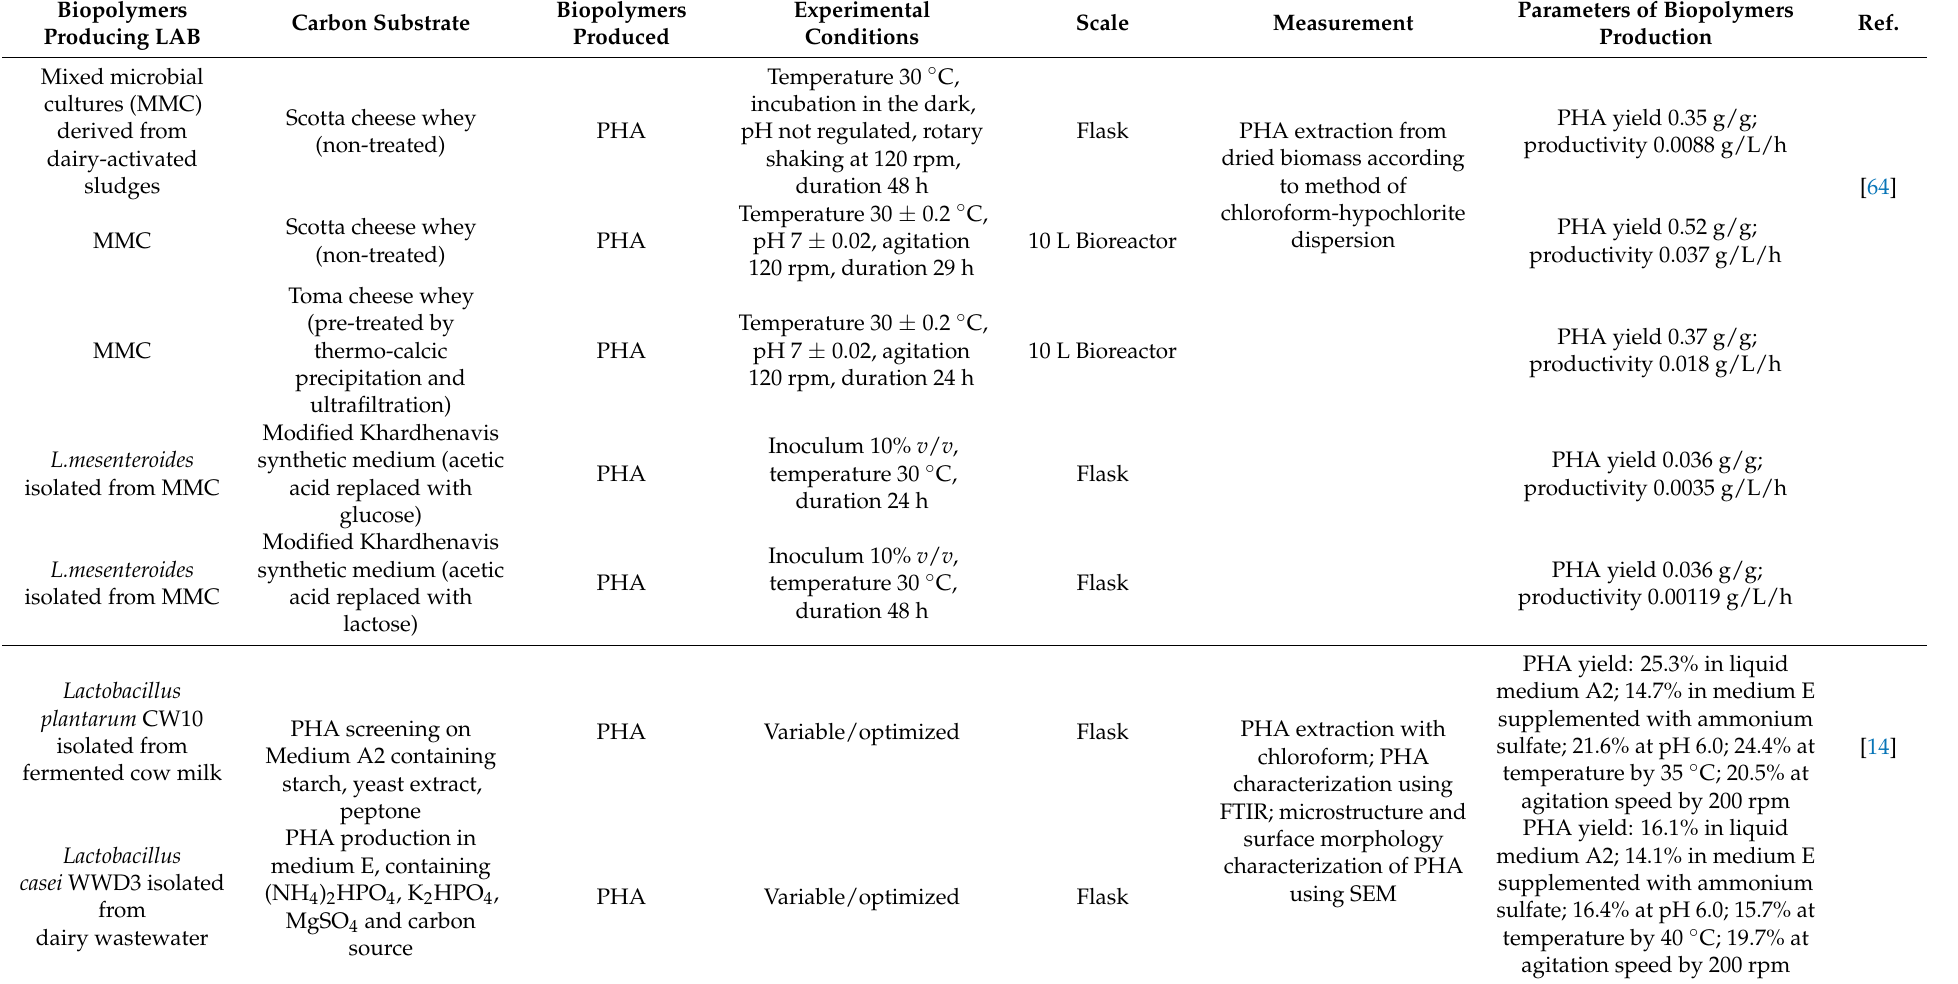
Table 1. Selected studies on biopolymers produced by lactic acid bacteria in a different